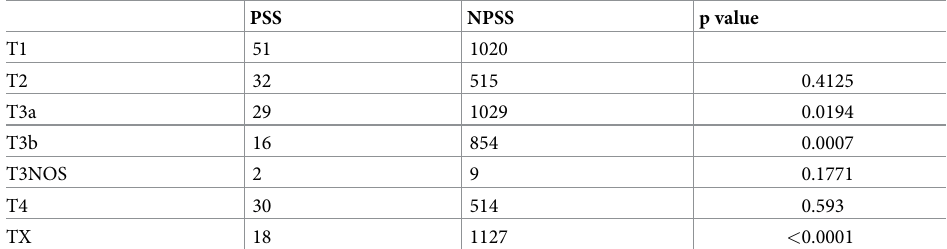
Table 6. Chi-square test of patients undergone primary site surgery at different T